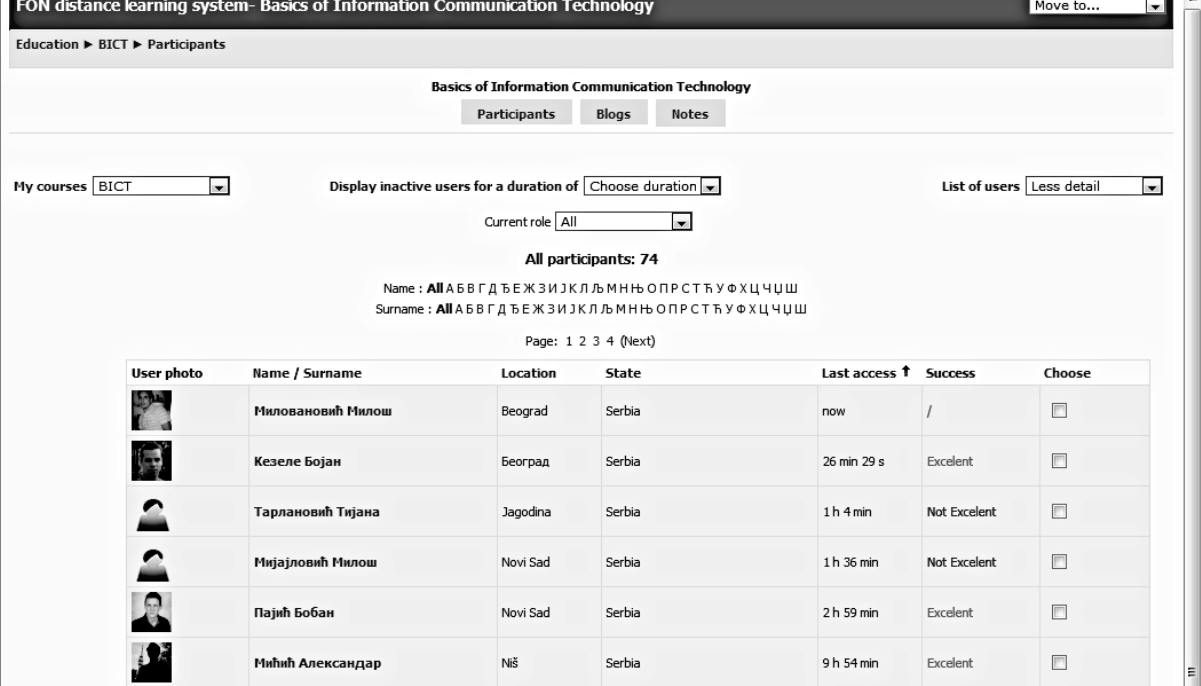
Fig. 7. New Moodle report for prediction of each